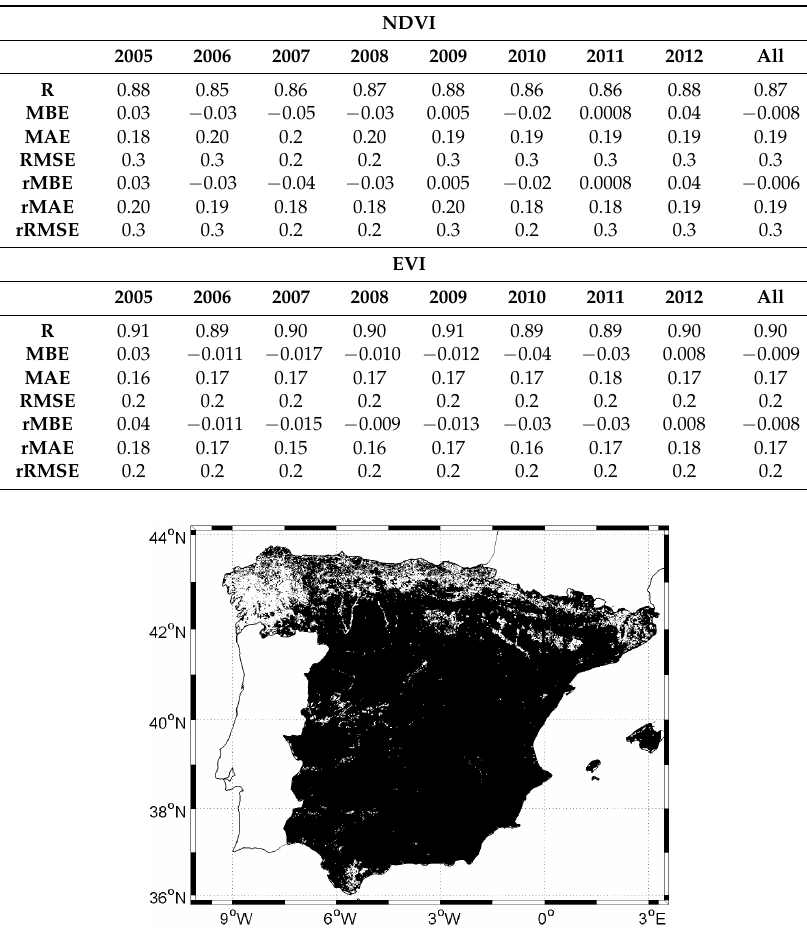
Table 3. Validation statistics for each iteration and for the whole data set (in this case, using the mean values of C 1 and C 2 shown in Table 2). MBE, MAE and RMSE are expressed in kg · m − 2 · yr − 1 . Results are shown for NDVI and EVI.